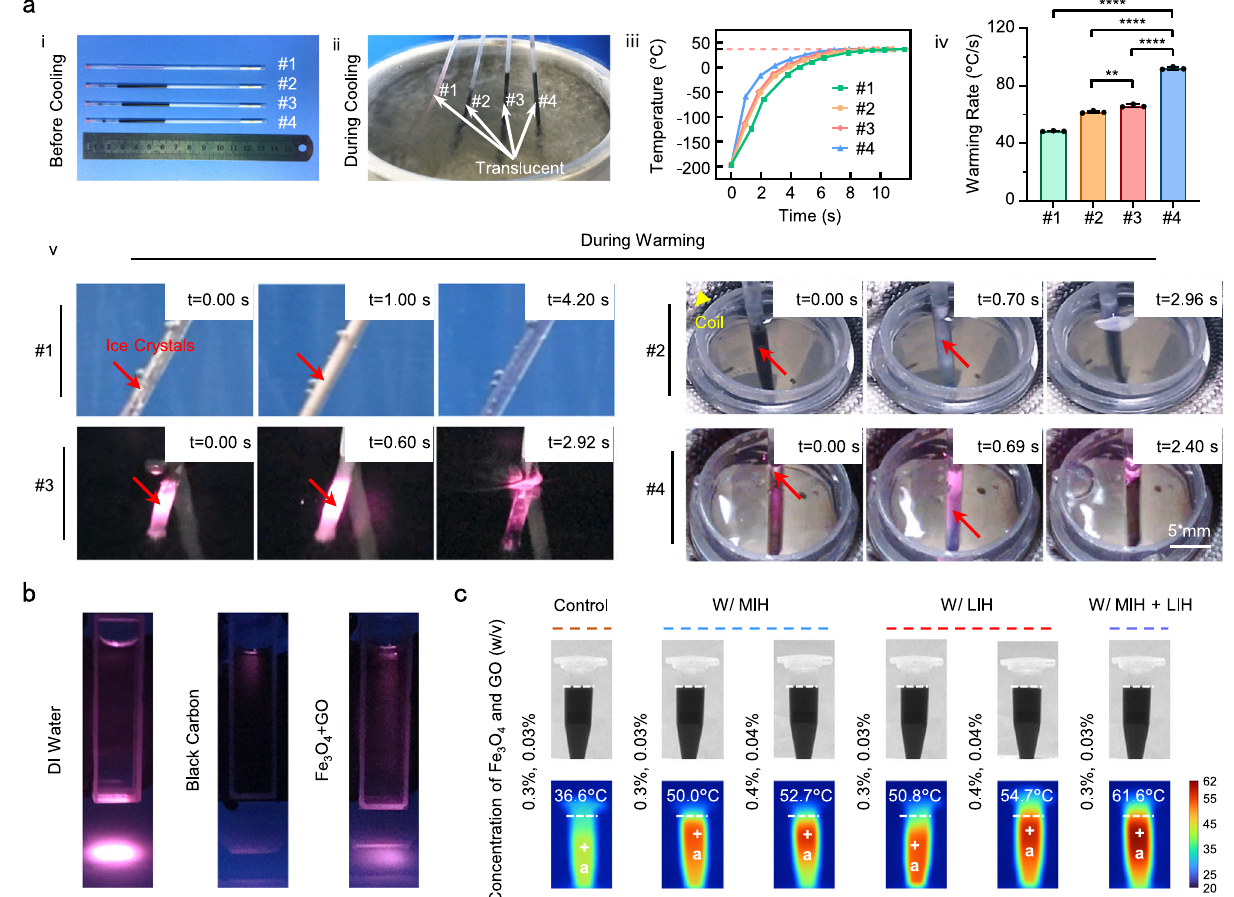
Fig.2|CoolingandwarmingofCPAsinplasticstrawsandthethermaleffectof NPs excited by near-infrared and magnetic fi elds. a Typical images display the cooling and warming of CPAs in plastic straws (PSs) and the thermal history of the nanowarming process.